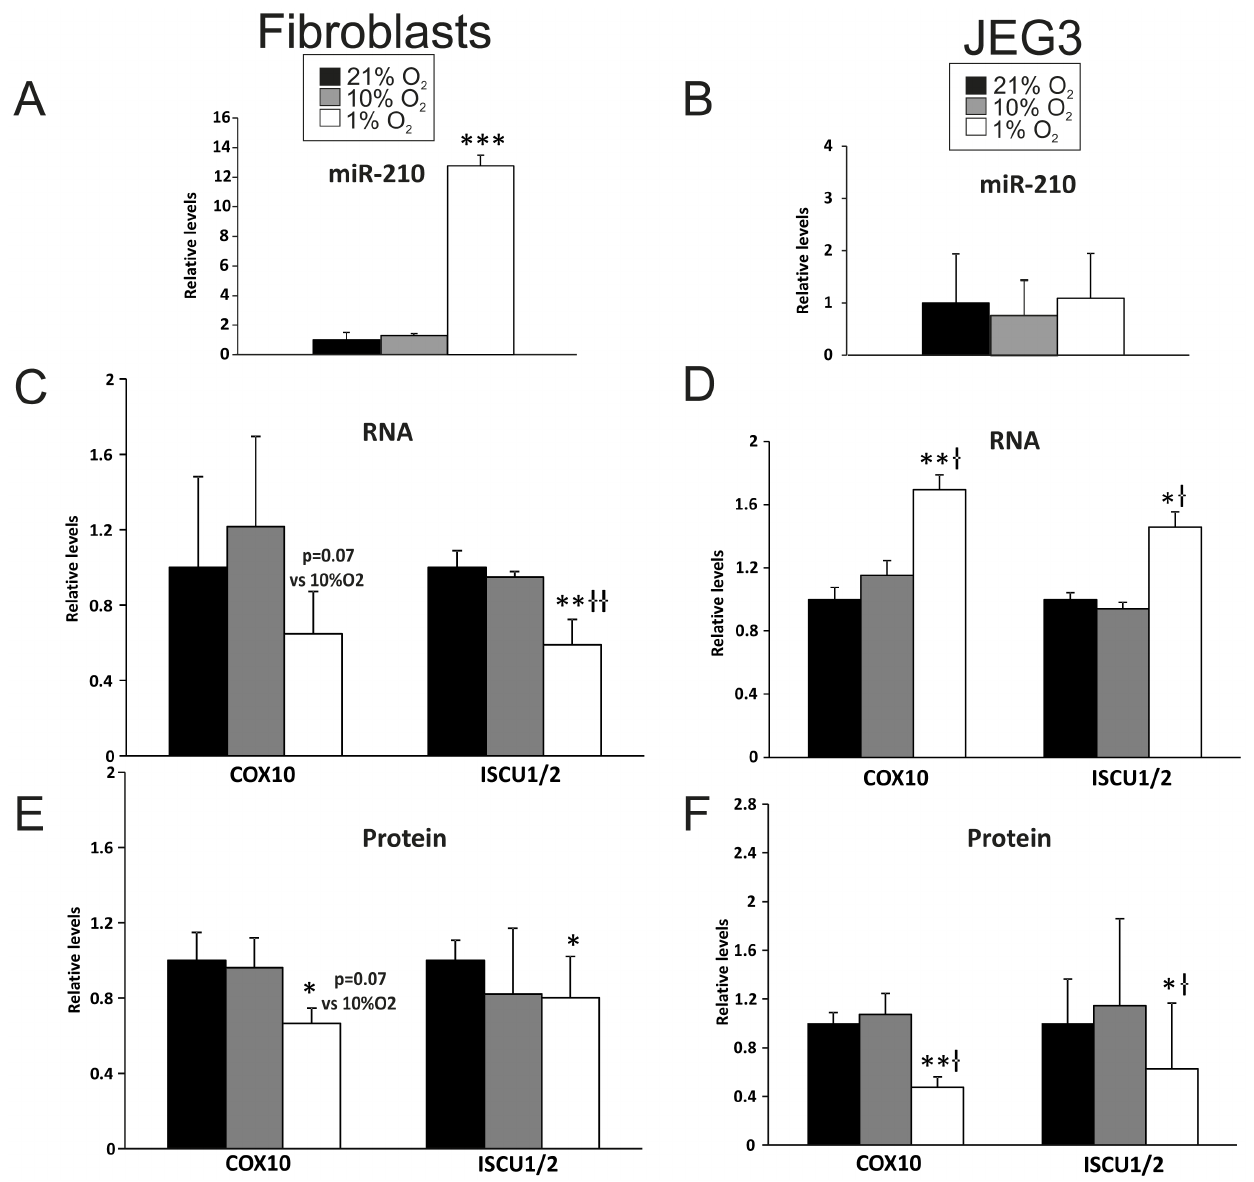
in A) fibroblasts and in B) JEG3. C, D) Transcript levels of COX10 and ISCU1/2 in C) fibroblasts and D) JEG3. E, F) Protein levels of COX10 and ISCU1/ 2 in E) fibroblasts and in F) JEG3. * p , 0.05, ** p , 0.01, *** p , 0.001 compared with cells cultured at 21% O2; { p , 0.05 compared with cells cultured at 10% O2. Minimum of three biological replicates per cell type for each condition were performed.